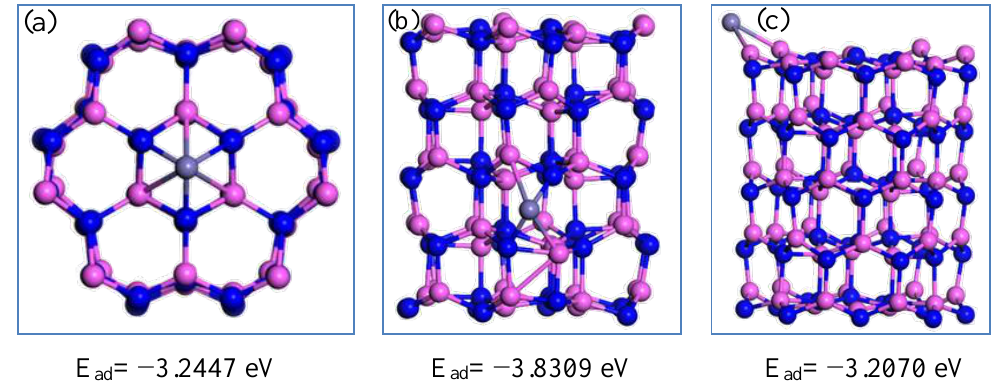
Figure 7. The chemisorption of Fe at different sites of the Al 60 N 60 cluster. The Al, N and Fe atoms are shown in pink, blue and gray. The Fe atom is located at the top, side and edge position of Al 60 N 60 cluster shown in a (top view), b and c , respectively.